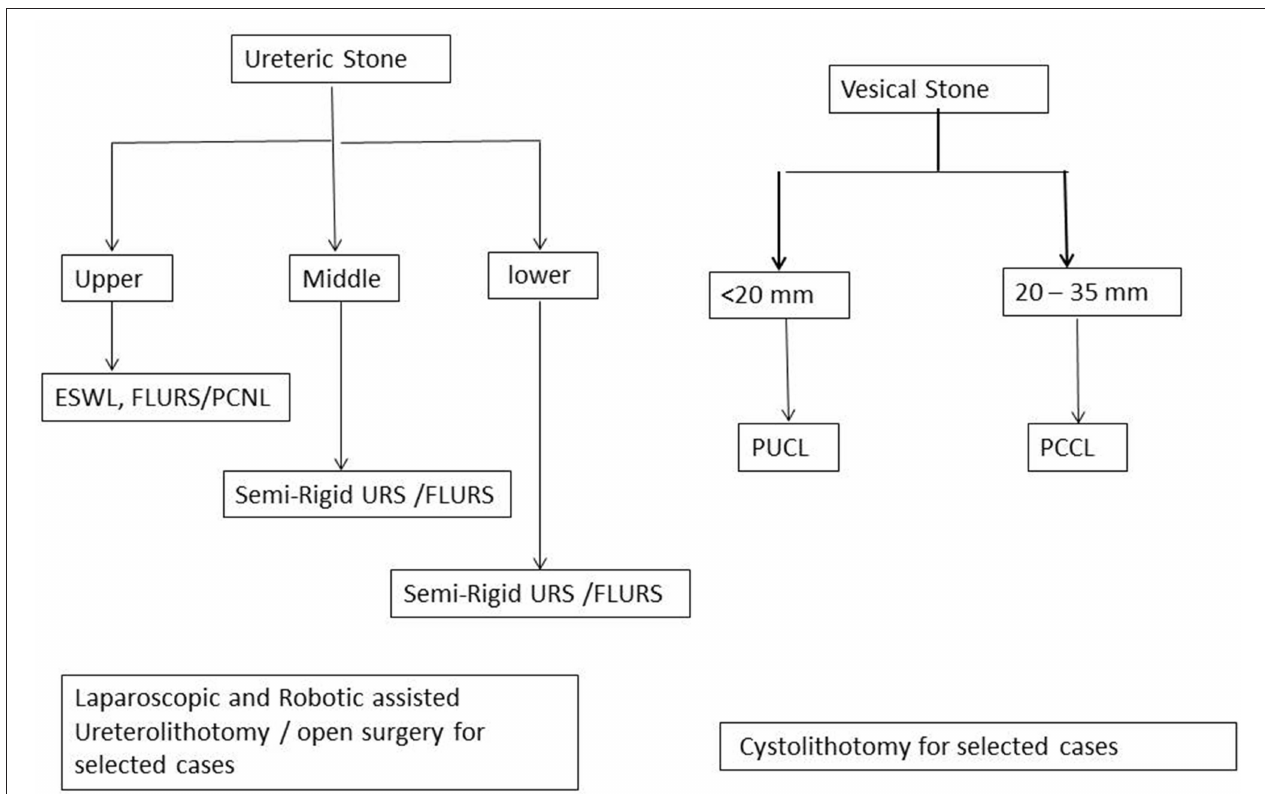
FIGURE 2 | Minimally invasive surgery for ureteric and vesical stone management algorithm.